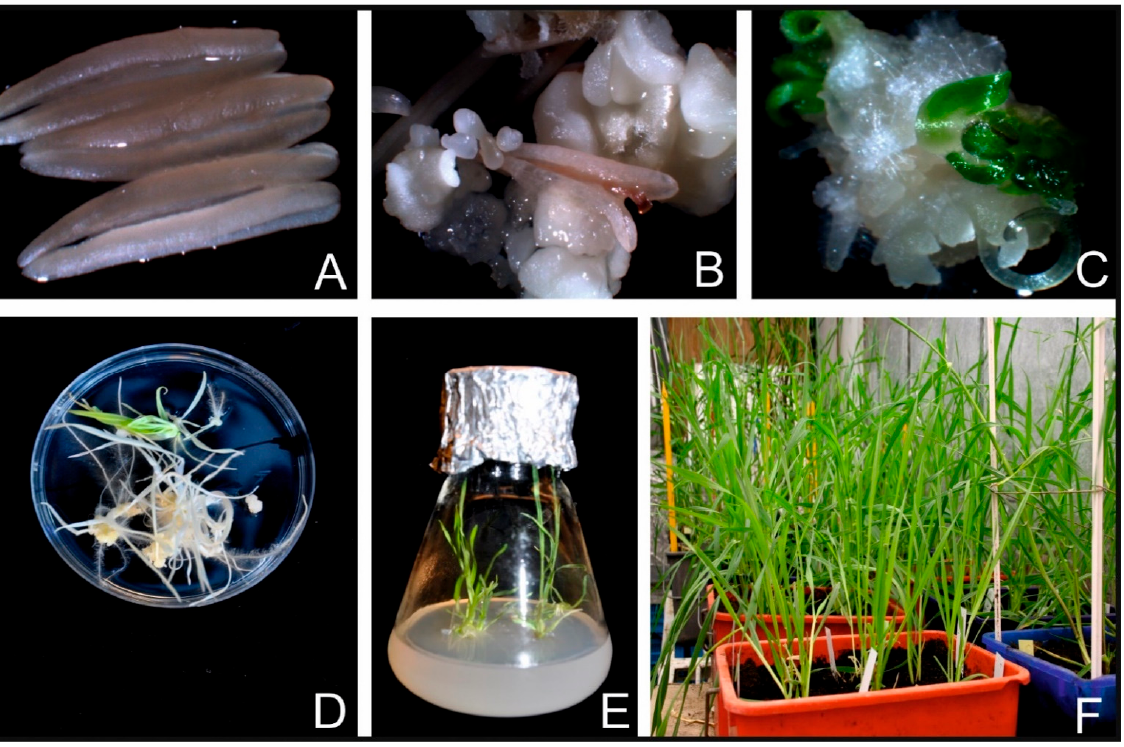
Figure 1. Schematic representation of plant regeneration via in vitro culture. ( A ) anthers on solid medium; ( B ) embryo formation from anther culture; ( C ) embryos and germinating embryos; ( D ) albino and green plants derived from anther culture, ( E ) green regenerants transferred to glass flask; ( F ) green developing regenerants in pots.